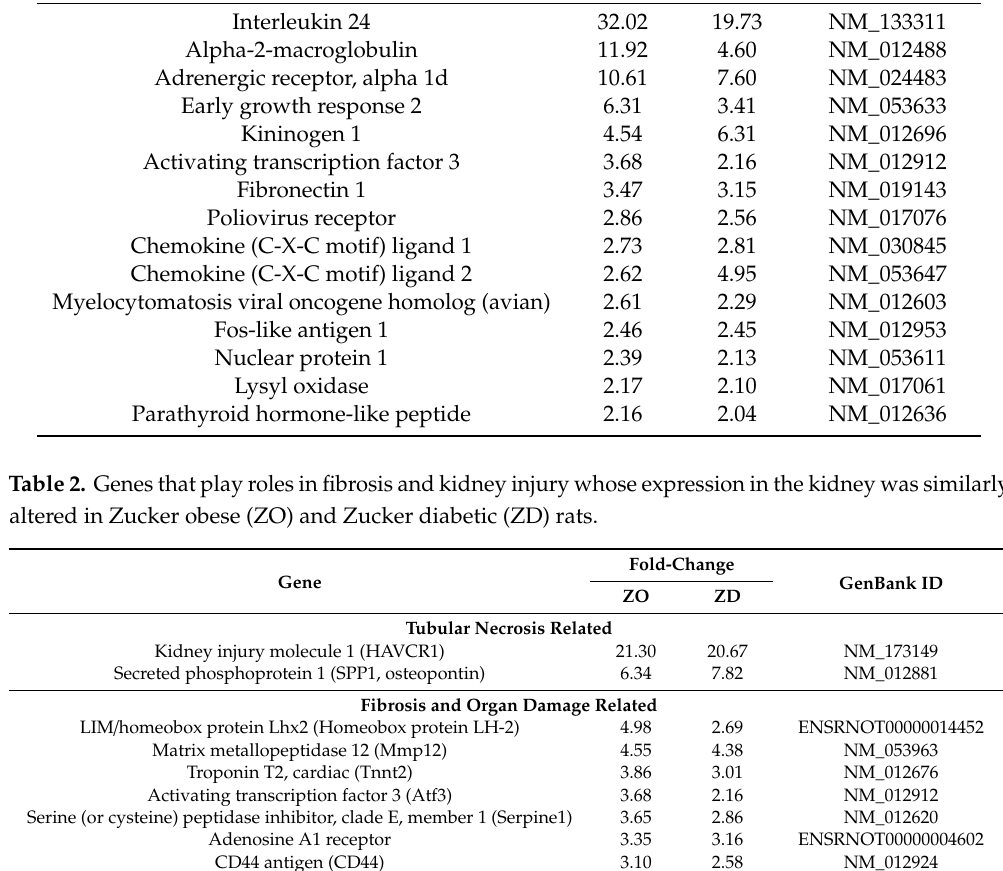
Serine (or cysteine) peptidase inhibitor, clade E, member 1 (Serpine1)